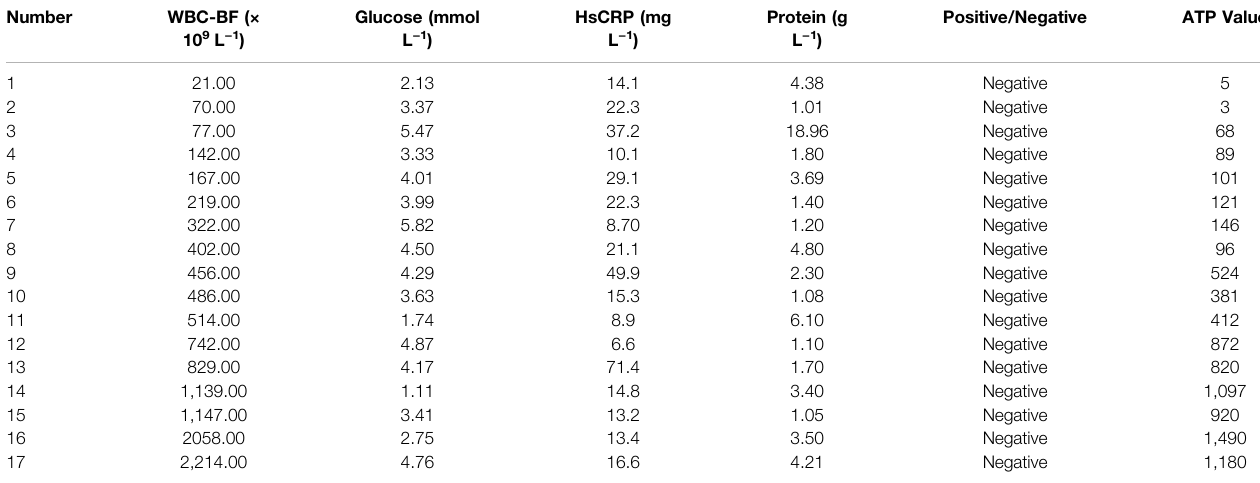
TABLE 3 | Data on CSF samples from 17 patients with suspected postoperative intracranial infection.